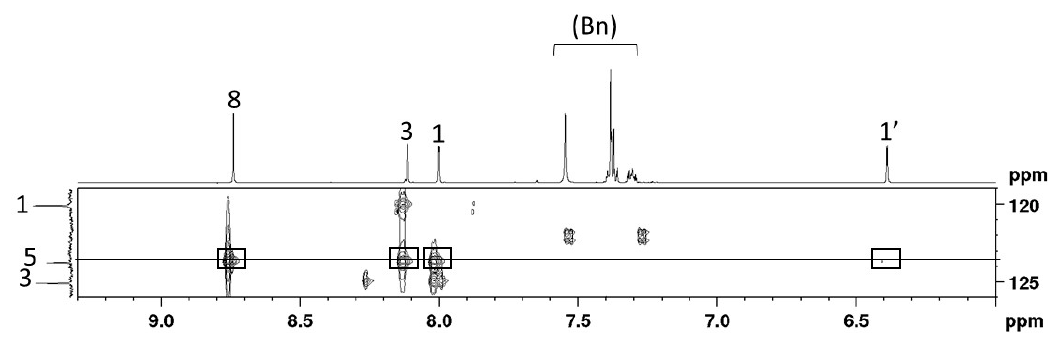
Figure 3. Decisive correlations with C5 on the N7-linked base in compound 29 are boxed in the HMBC spectrum. Labels correspond to assignments in proton and carbon